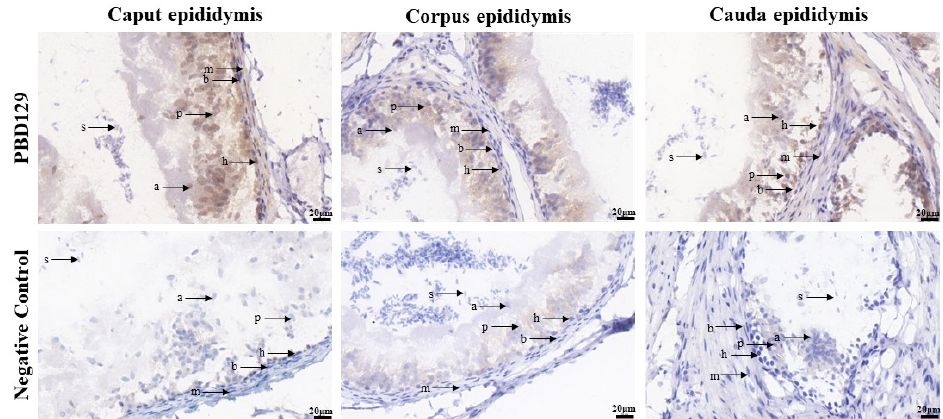
Figure 5. Immunohistochemistry analysis of pBD129 protein localization in the epididymis from adult boar. a, apical cells; b, basal cells; h, halo cells; m, myoid cells; p, principal cells; s, sperm.